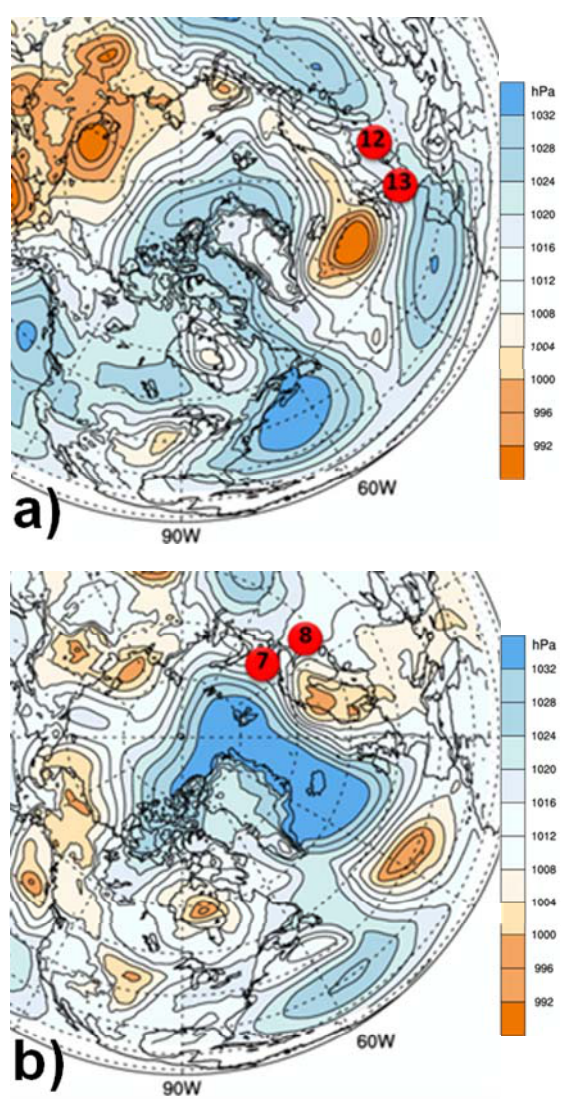
Fig. 17. Average location of trajectories comprising the largest group of trajectories in Fig. 15a (red circles) for (a) 12-13 days back from the flight and (b) 7-8 days back.